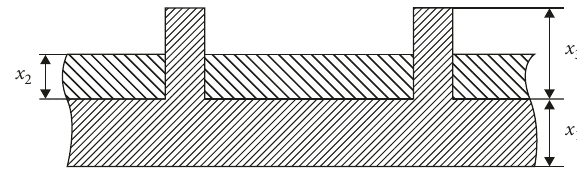
Figure 14: Structural design variables.